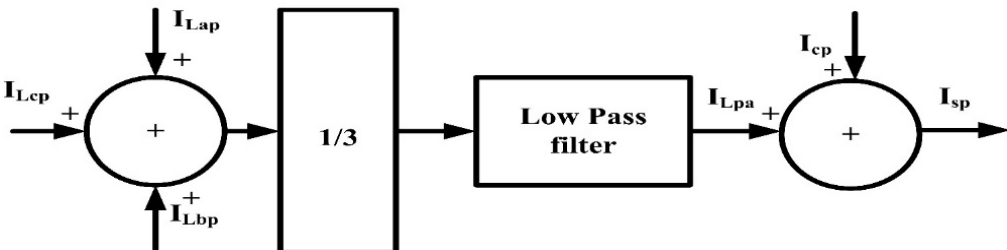
Figure 6. Design of amplitude of d-axis load current.